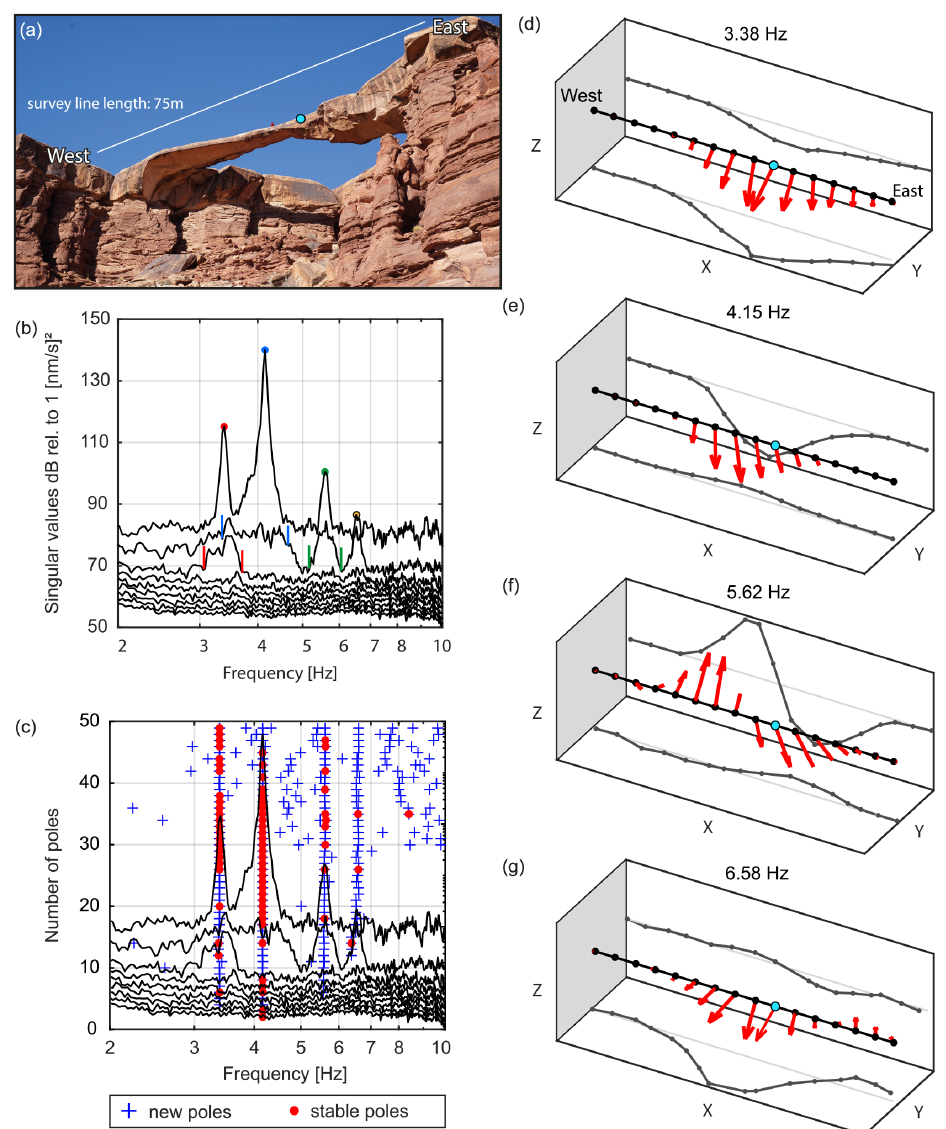
Figure 5. (a) Photograph of Musselman Arch and the (b) first nine singular values of the EFDD analysis. Solid markers indicate the resonant peaks, while vertical colored lines indicate the extent of the corresponding mode bell used for damping estimation. (c) Singular value plot with SSI-COV poles superimposed: stable frequency (blue cross) and stable mode shape (red circle). (d–g) 3D normal-mode shapes at the first four resonant frequencies (3.38, 4.15, 5.62, and 6.58Hz) with projections onto the X – Z and X – Y planes. The mode shapes are normalized to the reference indicated by the cyan marker. For better visibility, only one of the two parallel geophone lines is displayed, while the mode shapes of both lines are comparable (see Fig. A2). Photograph in panel (a) by Kathryn